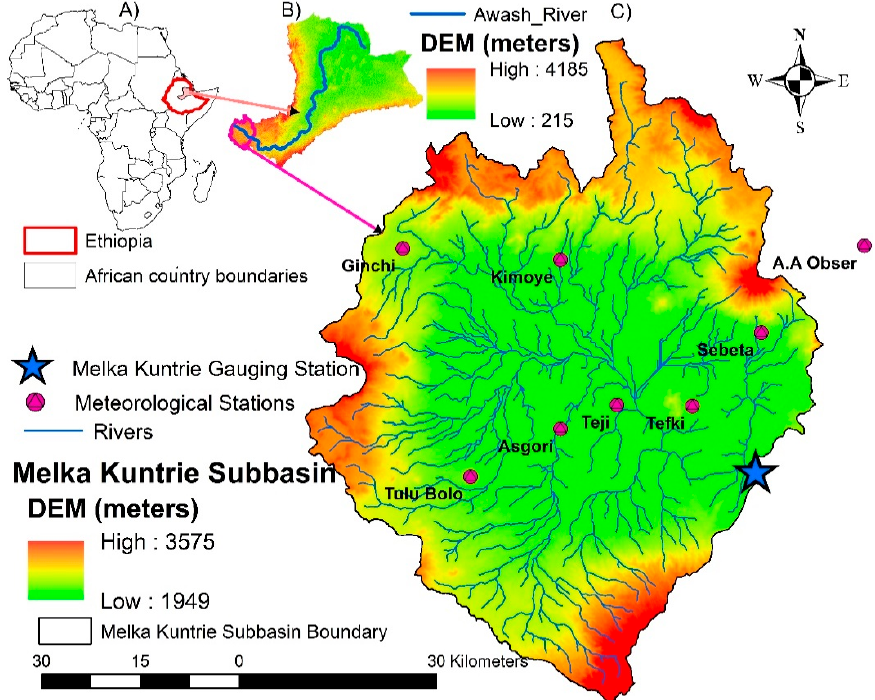
Figure 1. Map of the study area: ( A ) the continent of Africa; ( B ) the entire Awash river basin; ( C ) DEM and meteorological stations of the Melka Kuntrie subbasin.